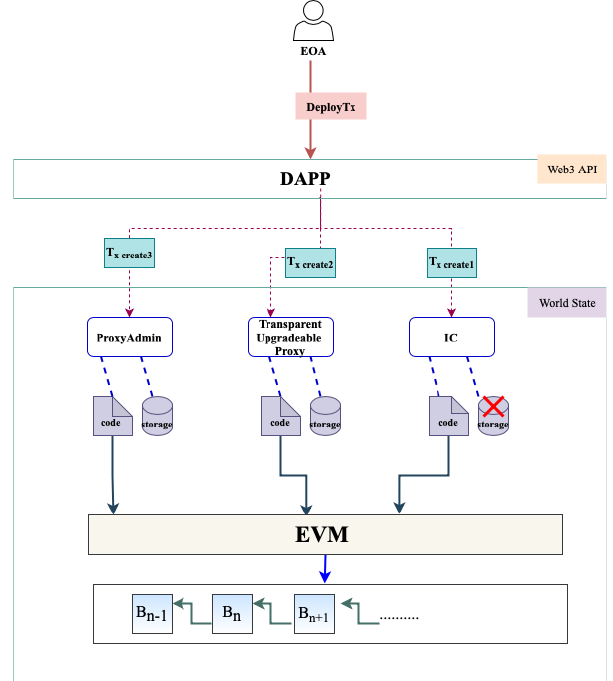
Figure 1. Process of deploying the TransparentProxy pattern